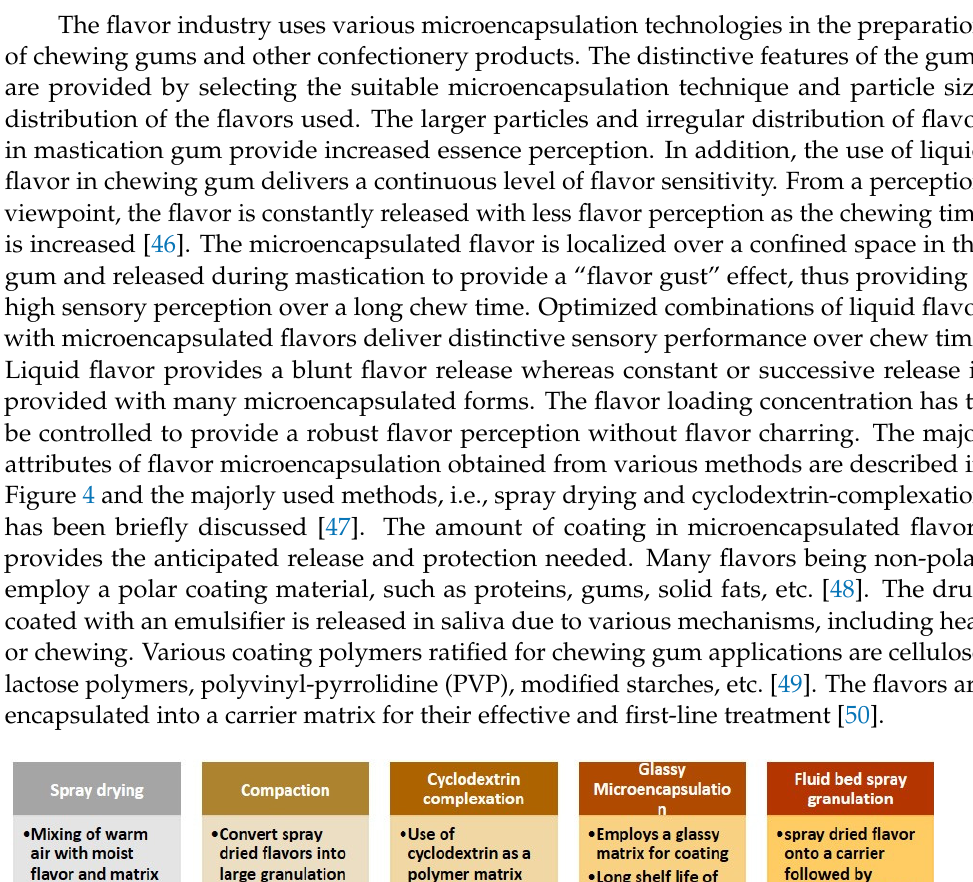
Figure 5. Polymers used for flavor microencapsulation in Medicated Chewing Gums.